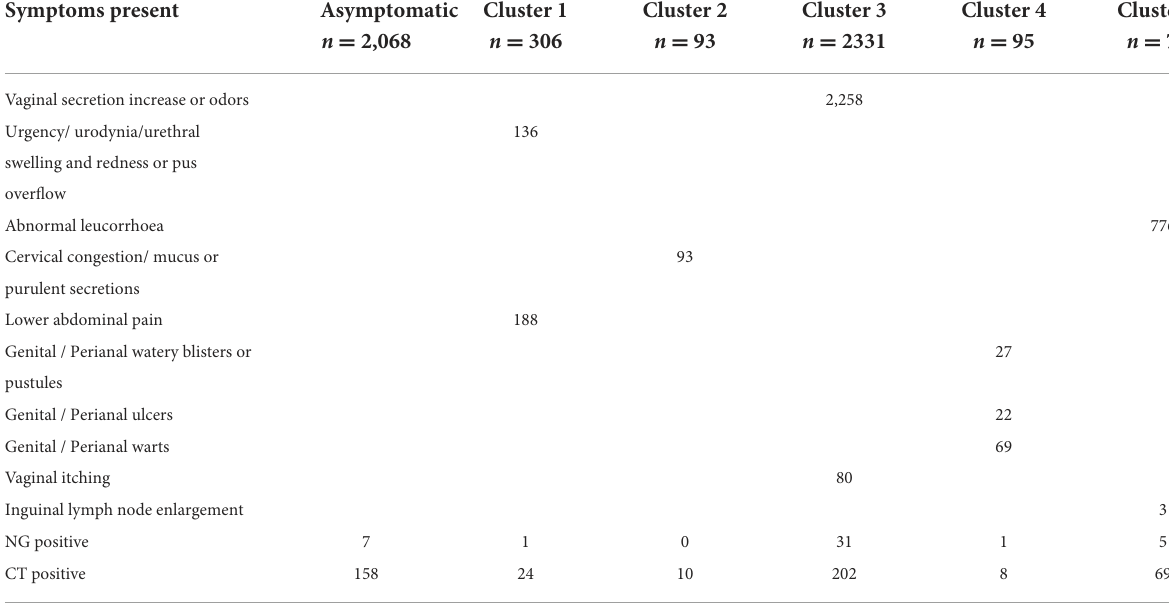
TABLE 4 Symptom clusters of the respondents in the women cohort ( N = 5,671).